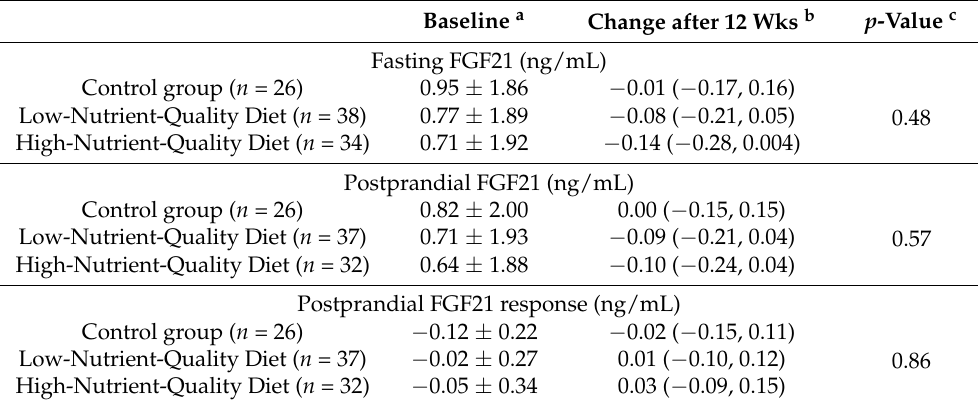
Table 2. Change in fasting plasma FGF21 and the postprandial FGF21 response upon a 12-week energy restriction diet (low or high nutrient quality) compared to a control group.